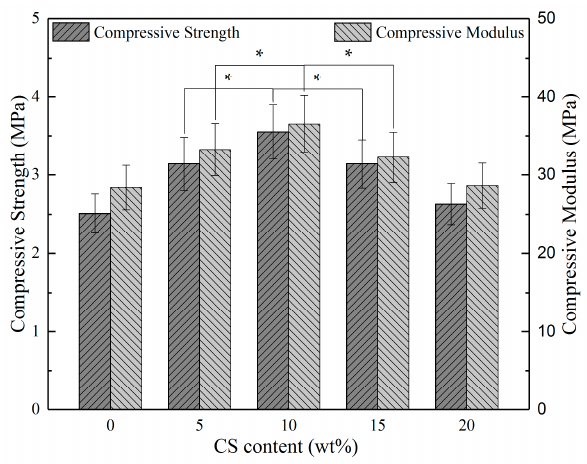
Figure 6. The compressive strength and compressive modulus of PHBV/CS scaffolds as a function of CS content; * represents p < 0.05.